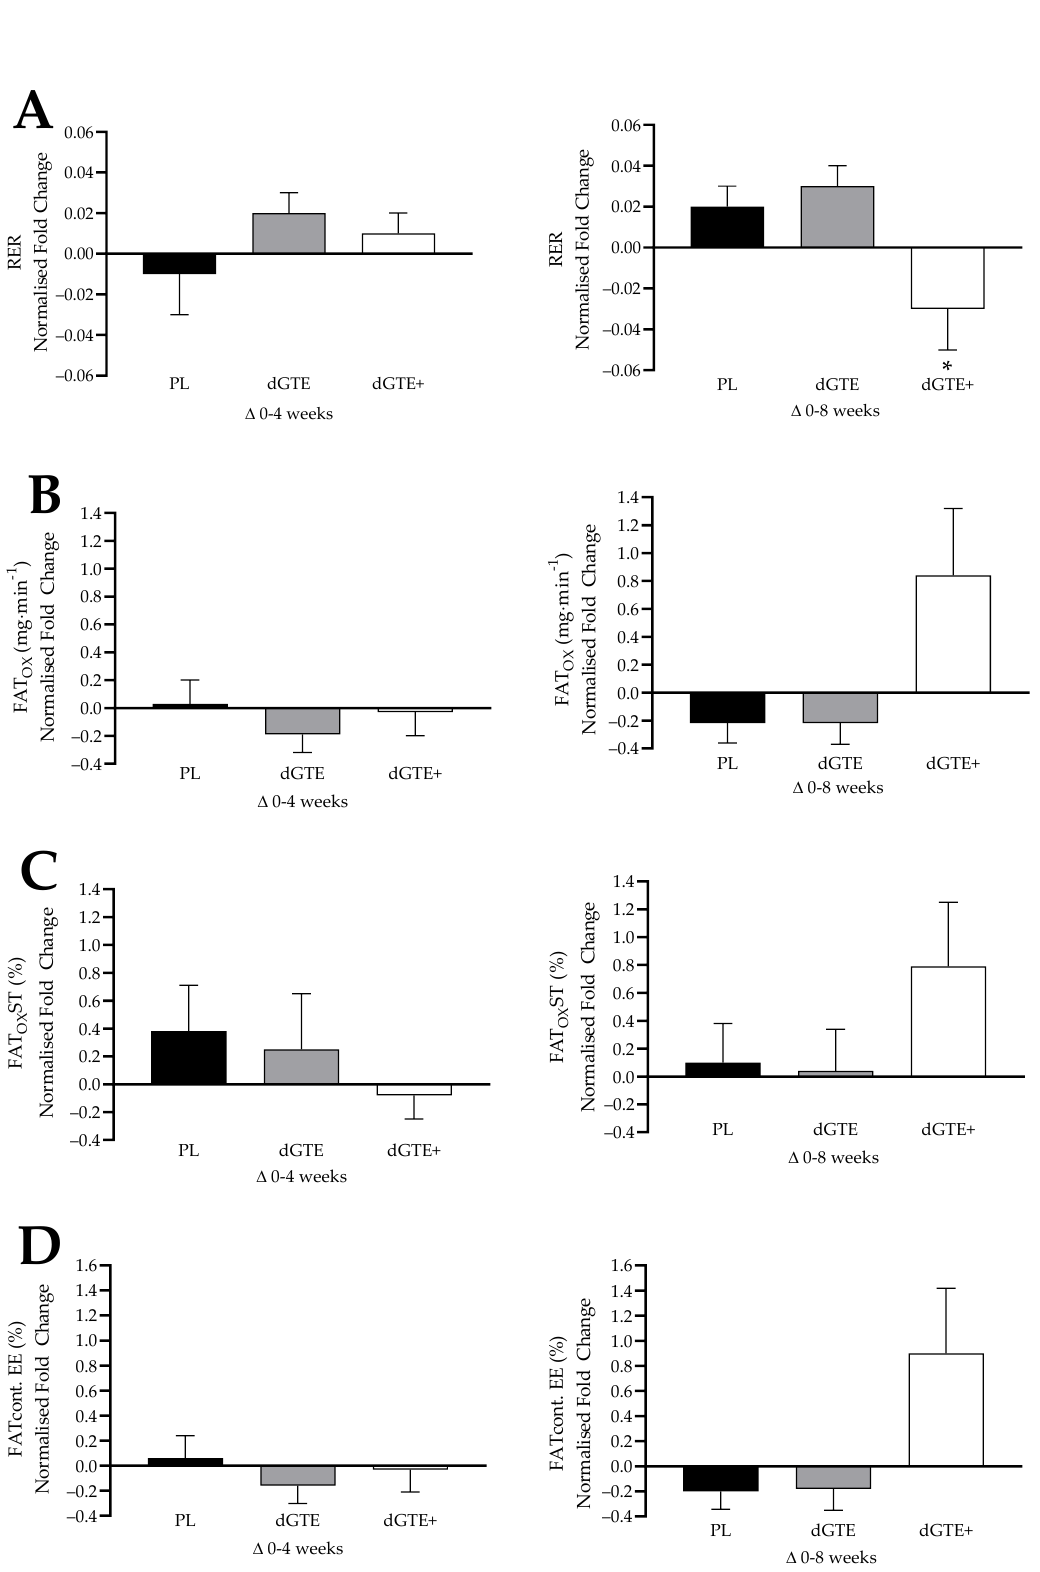
Figure 2. Mean normalised fold change for fat oxidation parameters during steady state exercise between groups by week 4 ( ∆ 0–4 weeks) and week 8 ( ∆ 0–8 weeks) of the intervention; showing ( A ) respiratory exchange ratio (RER), ( B ) fat oxidation rate (FAT OX ), ( C ) fat oxidation stability (FAT OX ST), and ( D ) contribution of fat to total energy expenditure (FATcont.EE). PL = placebo; dGTE = decaffeinated green tea extract; dGTE+ = decaffeinated green tea extract with antioxidants. * significantly different to dGTE only ( p = 0.034).